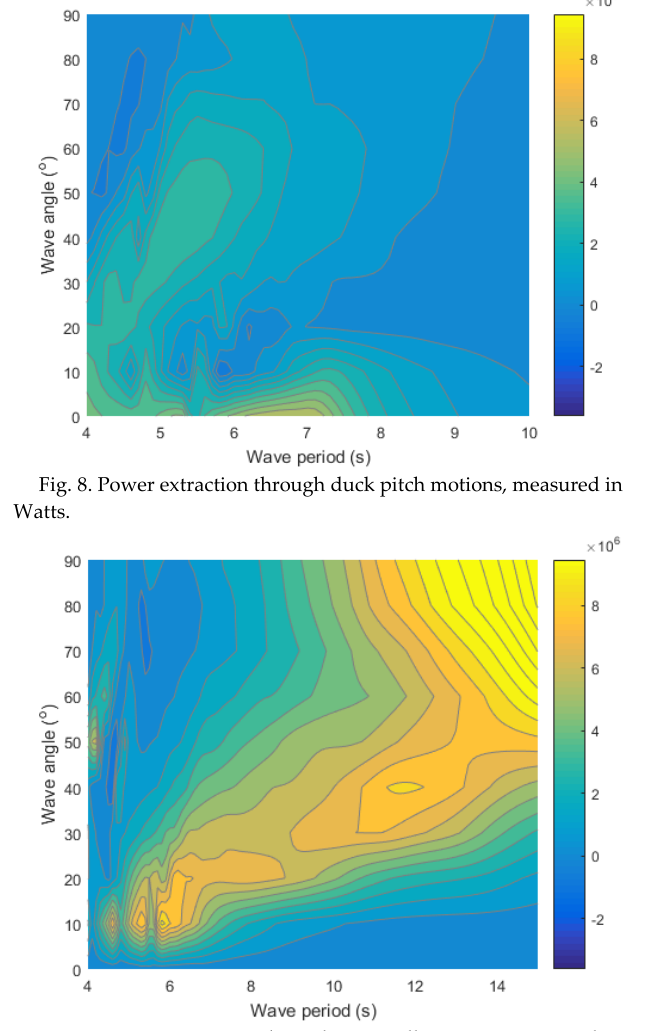
Fig. 9. Power extraction through joint roll motions, measured in Watts.